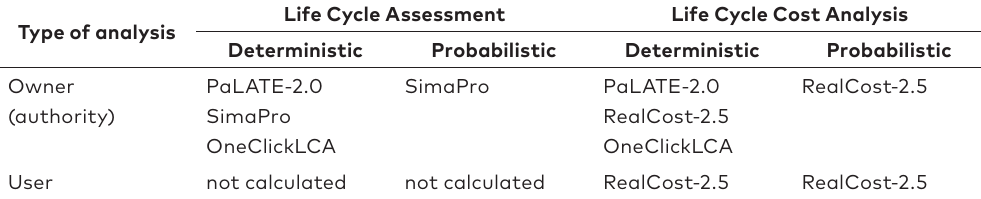
Table 2. Limits on the use of different